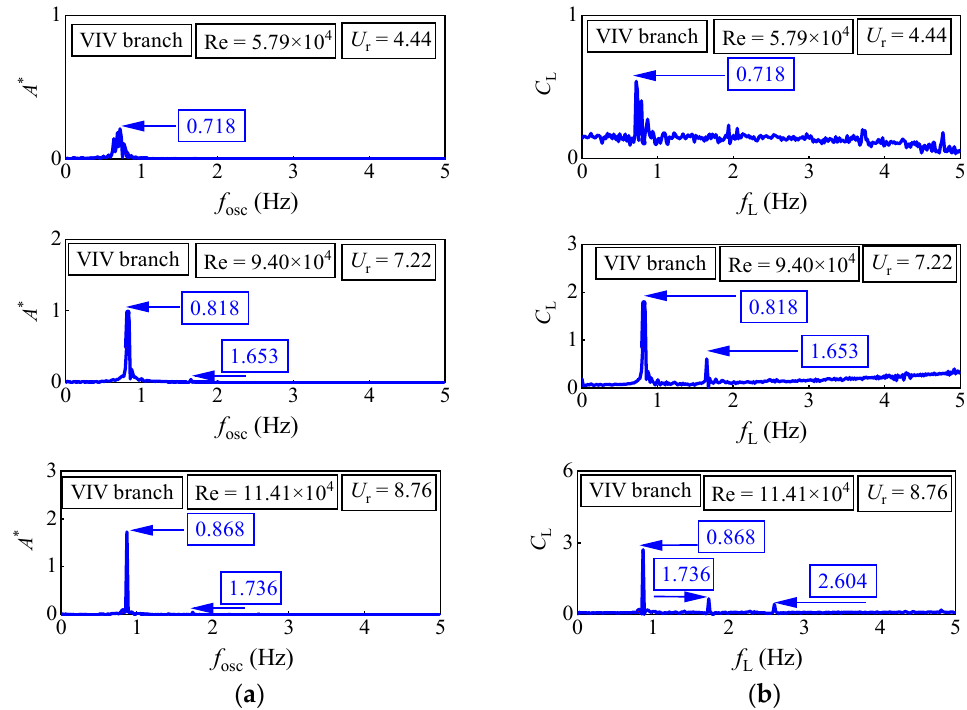
Figure 15. Spectral of Cir-T-Att with D = 0.12 m, R e = 5.79 × 10 4 ~1.38 × 10 5 . ( a ) Displacement spectral. ( b ) Fluid force spectral.